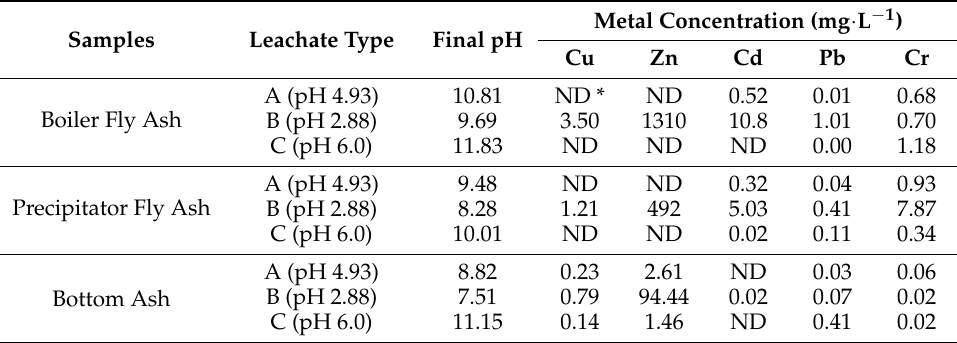
Table 1. Metal concentrations in the TCLP leachate of MSWI